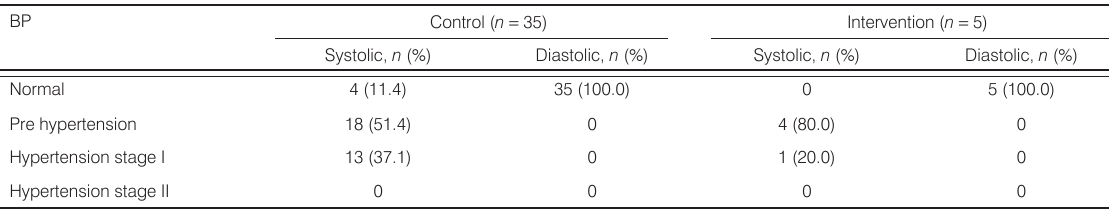
Table 5. Distribution of number BP values among drop out of participant in control and intervention